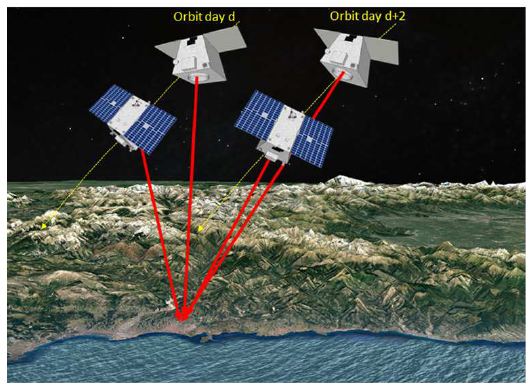
Figure 1. CO3D optical satellites